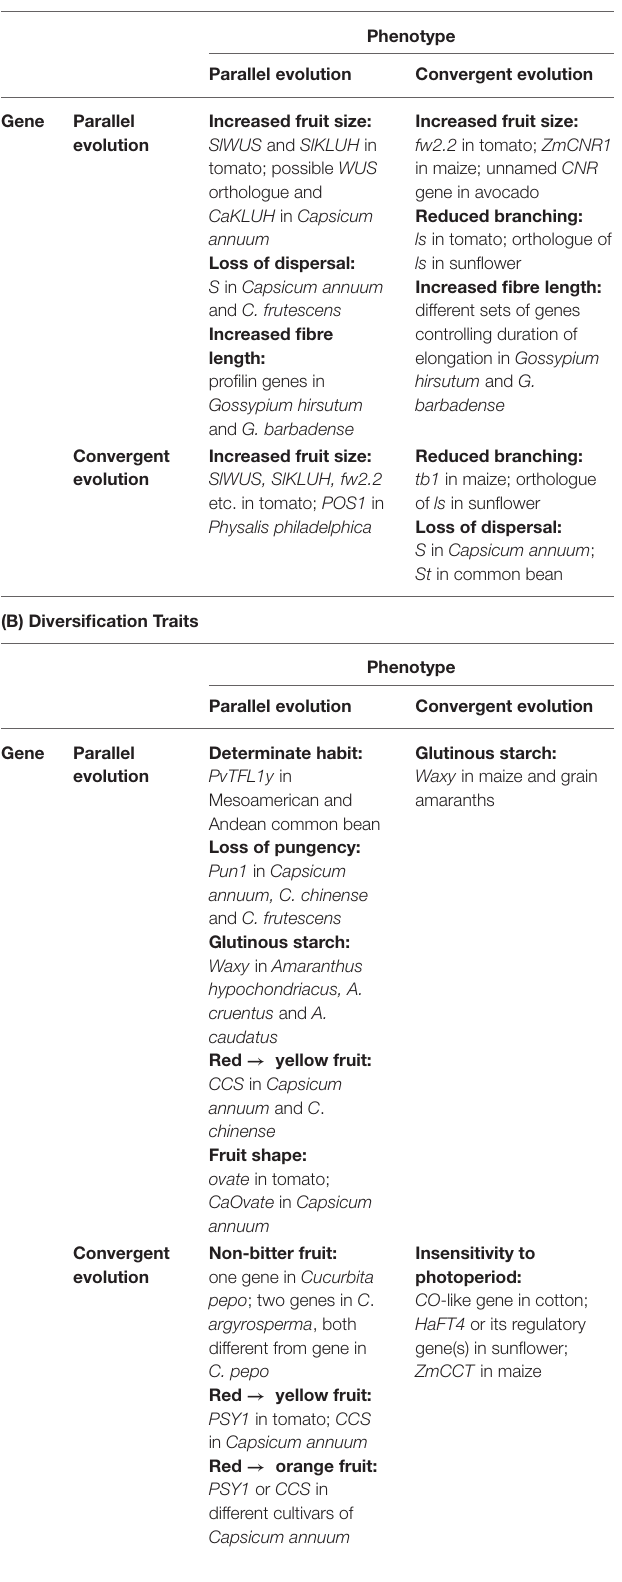
TABLE 3 | Examples of parallel and convergent evolution at levels of phenotype and gene in some domestication and diversification traits. (A) Domestication